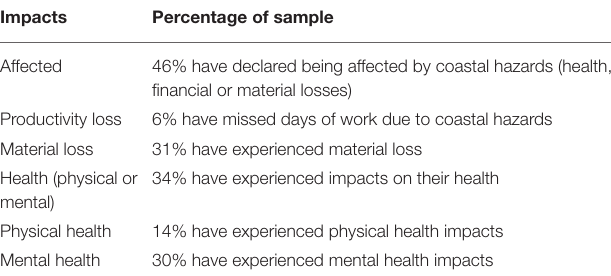
TABLE 2 | Type of major impacts on respondents ( n = 101). ( Table 3 ). Oaxaca (1973) developed a decomposition method for calculating the income gap between men and women. We used the same method to assess the difference between affected and unaffected respondents for our different variables. The